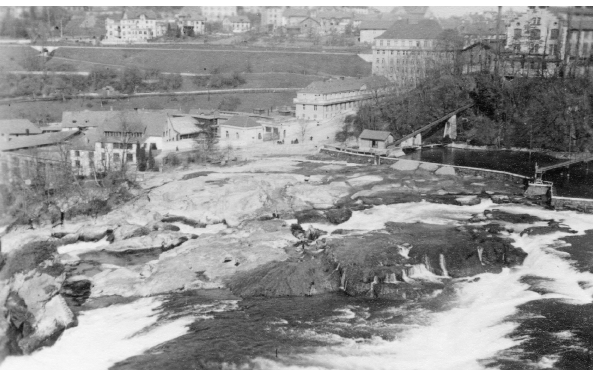
Figure A2. The Rhine Falls near Neuhausen (Switzerland) at low water in 1921. Photograph made on 22 March 1921 when the wa- ter level reached a historically low level. Source and copyright: Schweizerisches